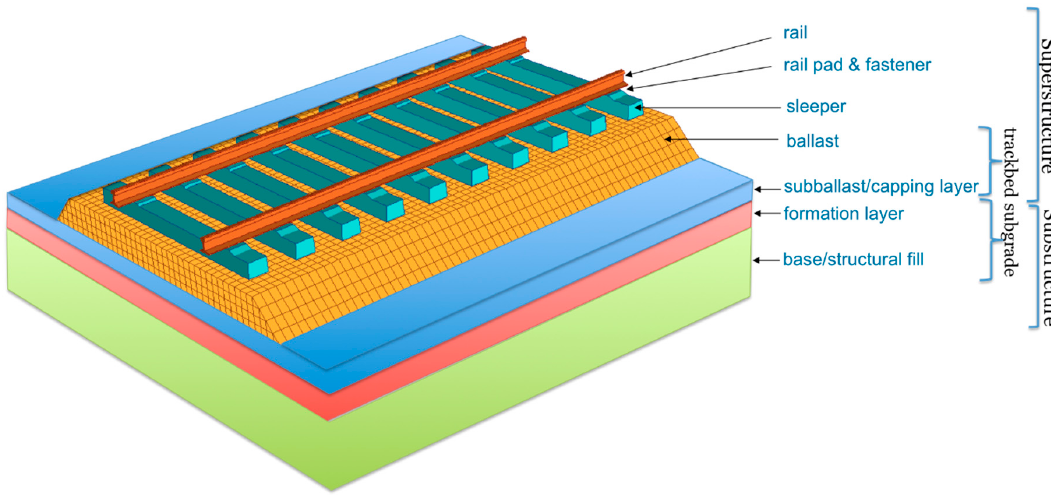
Figure 1. Railway Figure 1. Railway components. Table 2. Railway cost.